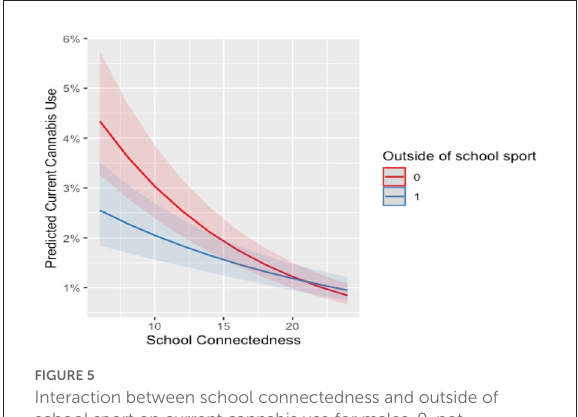
FIGURE5 Interaction between school connectedness and outside of school sport on current cannabis use for males. 0, not participating; 1, participating. Line and shade, mean and SE.